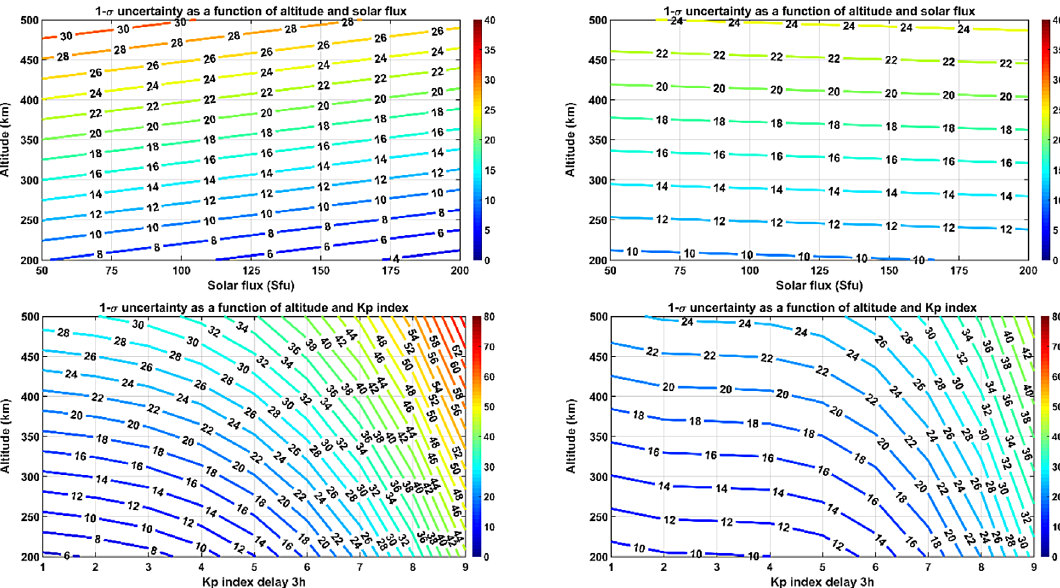
Fig. 13. Contour level plot of the 1- r uncertainty (in percent) as a function of solar and magnetic drivers: (left) Accelerometer uncertainty ’ s model, (right) HASDM uncertainty ’ s model. (Top) altitude and solar fl ux Fp , (bottom) altitude and magnetic index K p .